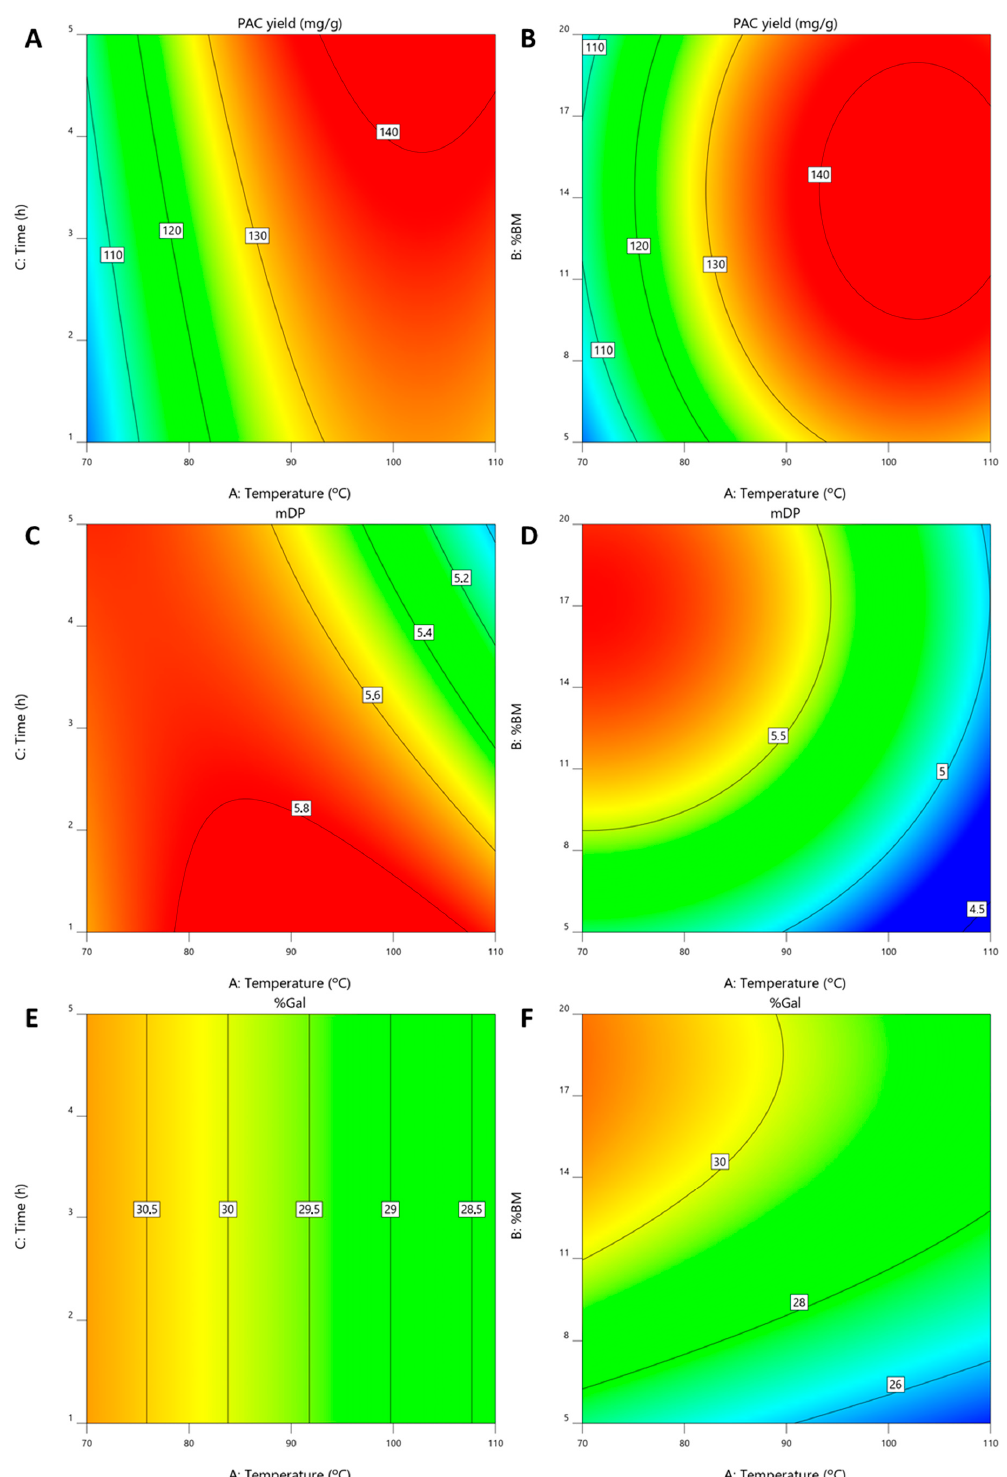
Figure 5. Contour plots obtained for extraction conditions optimization for ( A , B ) Y PAC , ( C , D ) mDP and ( E , F ) %Gal.